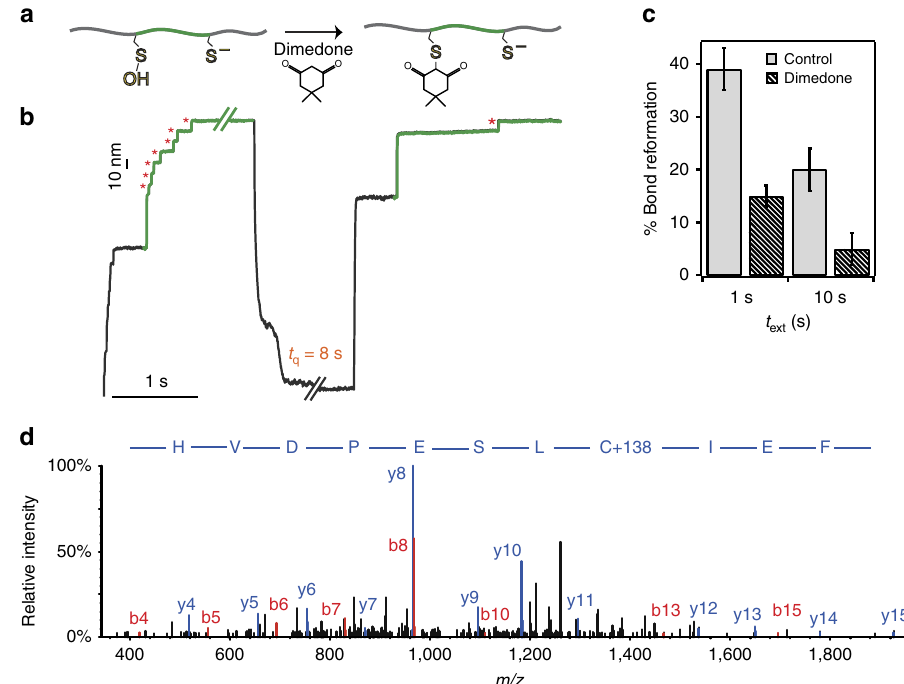
Figure 5 | Dimedone selectively targets sulfenic acid and blocks oxidative folding. ( a ) The newly formed sulfenic acid moiety can be selectively trapped by dimedone. ( b ) When an individual (I27 E24C–K55C ) 8 polyprotein is reduced and stretched in the presence of a 30mM solution of dimedone, the subsequent test pulse shows a dramatic decrease in the presence of both B 10nm (red asterisks) and B 15nm steps, implying that oxidative folding is hindered. ( c ) The percentage of disulfide bond reformation (and hence of successful folding) decreases with t ext , the time the protein remains extended and stretched at a high force. For t ext ¼ 1s, the % reformation decreases down to 15.6 ± 2.3% in the presence of dimedone. On increasing t ext ¼ 10s, the percentage of reformation is further reduced (6.0 ± 3.3%). ( d ) The MS/MS fragmentation spectra of an I27 E24C–K55C monomer under high-pH conditions provided unambiguous evidence of the presence of the dimedone, hallmarked by a cysteine mass shift of D m / z ¼ þ